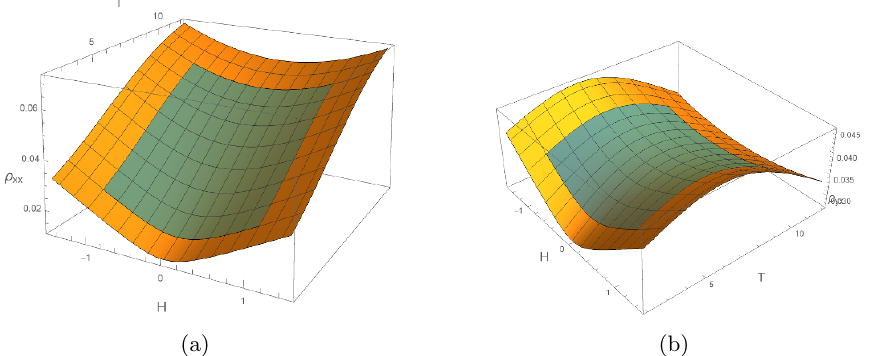
Figure 20 . The temperature and the magnetic (cid:12)eld dependence of (a) parallel, (b) transverse magnetoresitivity.